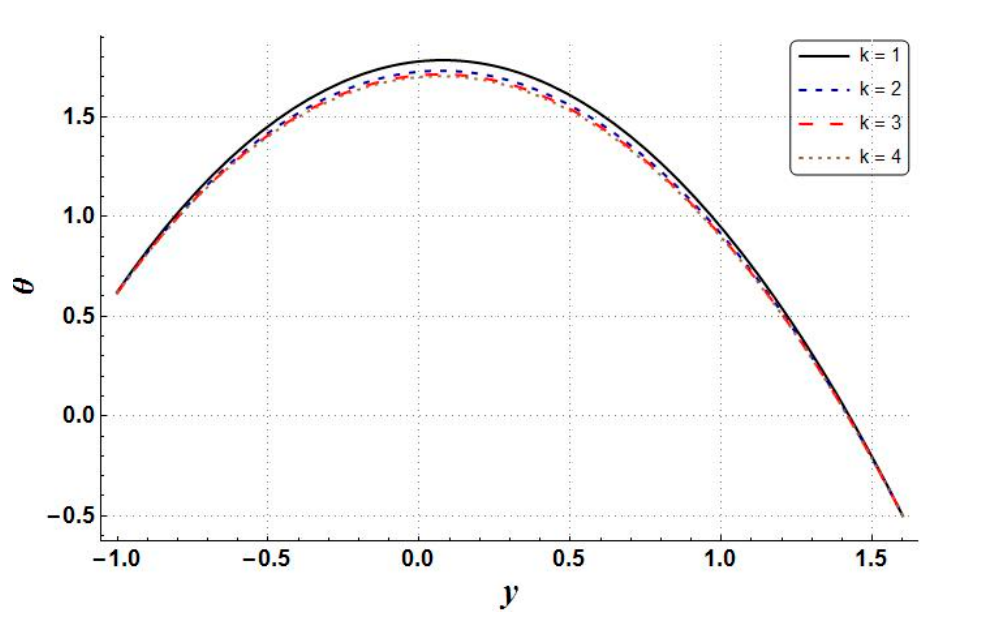
Figure 5. Influence on θ through changing values of k , where γ = π